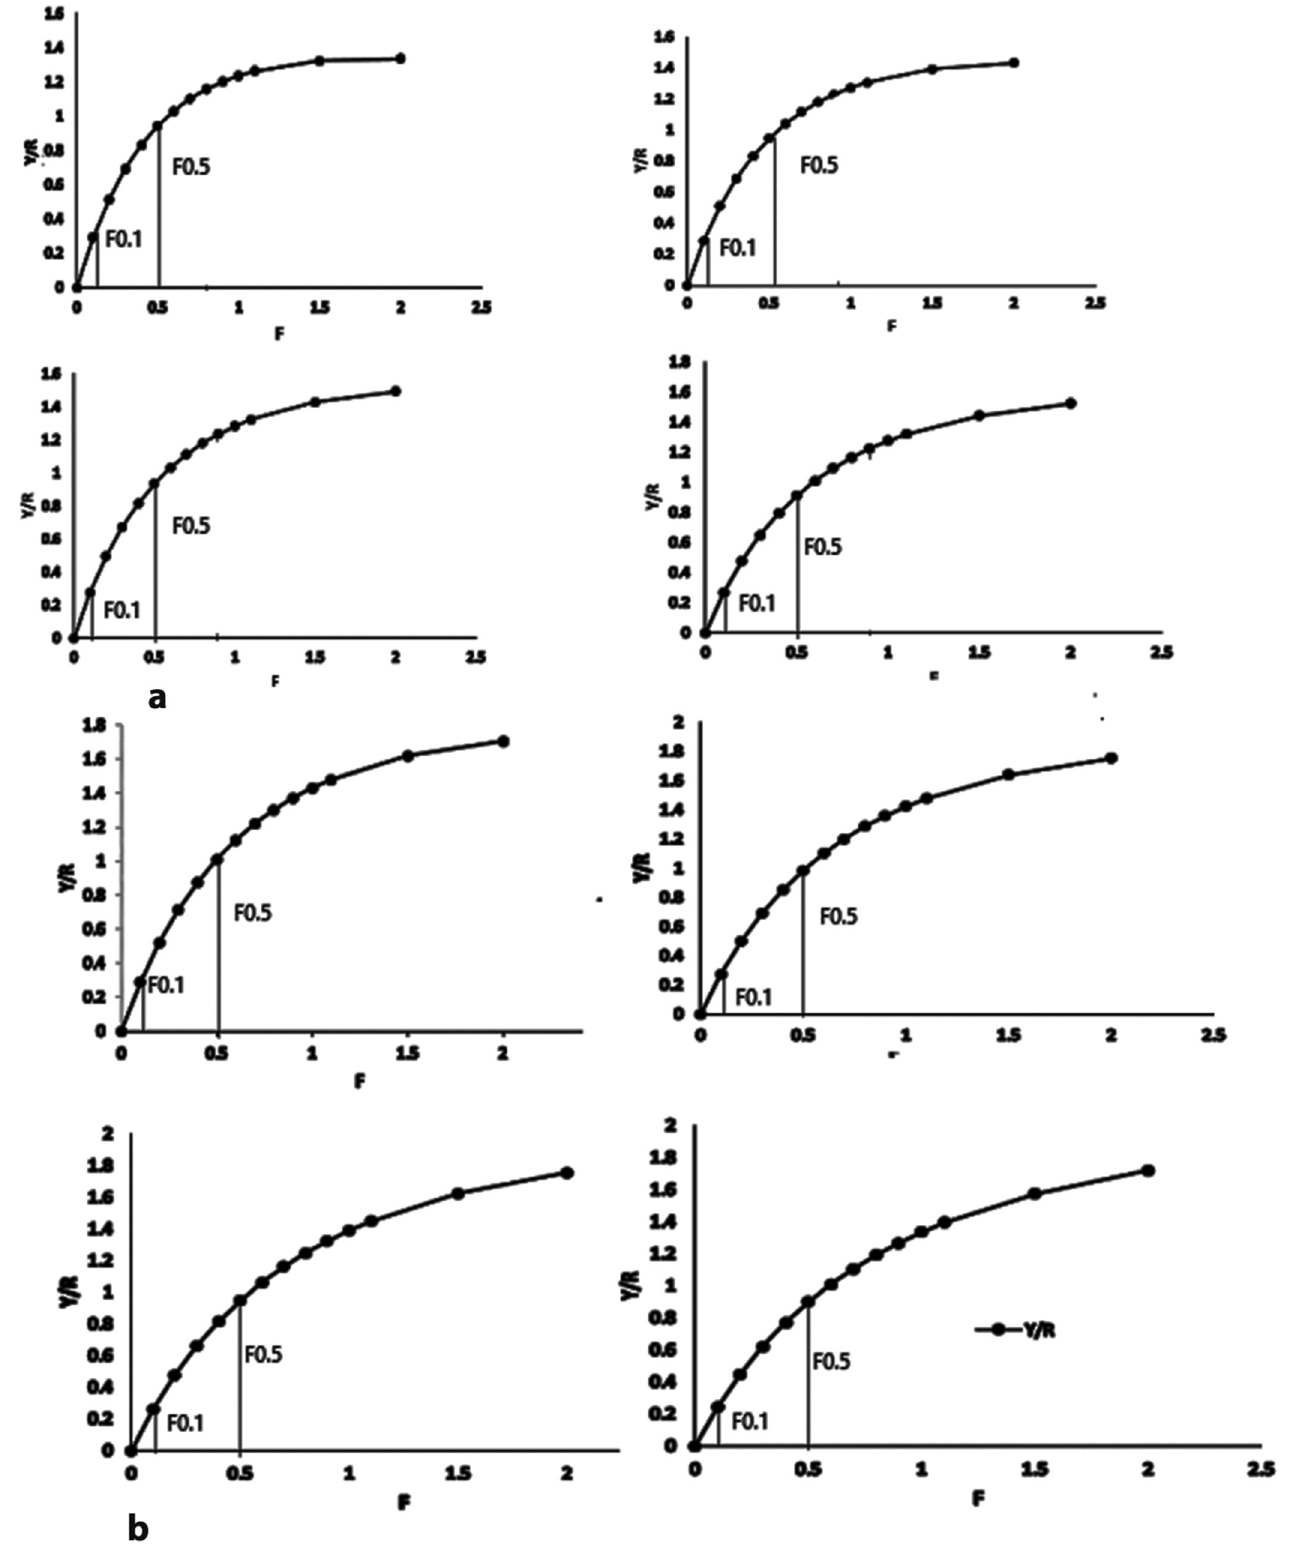
Fig. 8. Curves of yield per recruit on fi shing mortality (F) for females (a) and males (b) estimated for age at capturet c =0.5, 0.6, 0.7 and